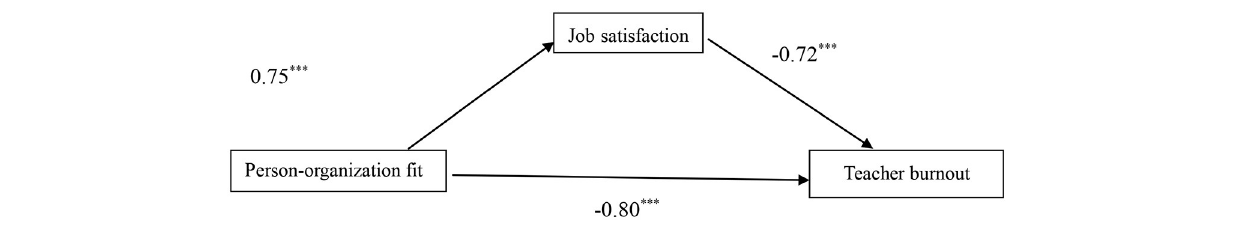
Teachers with a high degree of person-organization fit are more satisfied with their organizations and careers (27).